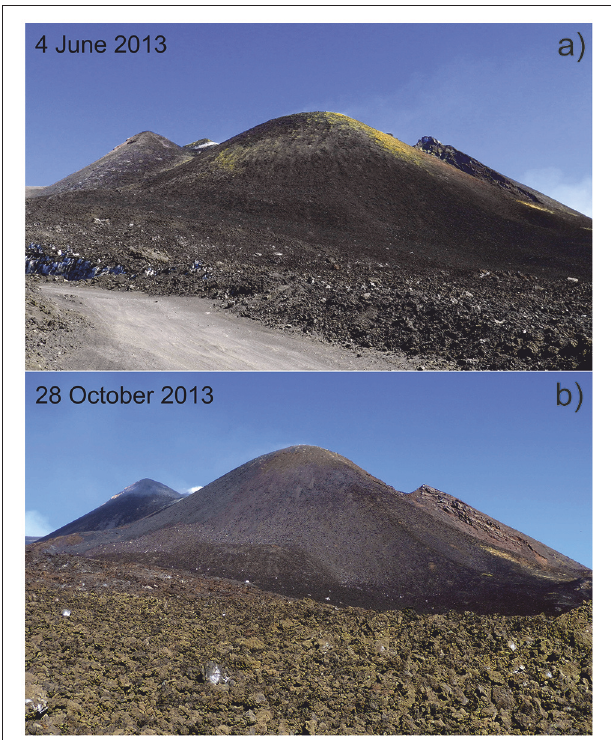
FIGURE 2 | The NSEC cone seen from south-southeast (a) before and (b) after the 26 October 2013 paroxysmal episode. Vertical growth of the cone, by ∼ 30m, is well visible in (b) . Photos by B.